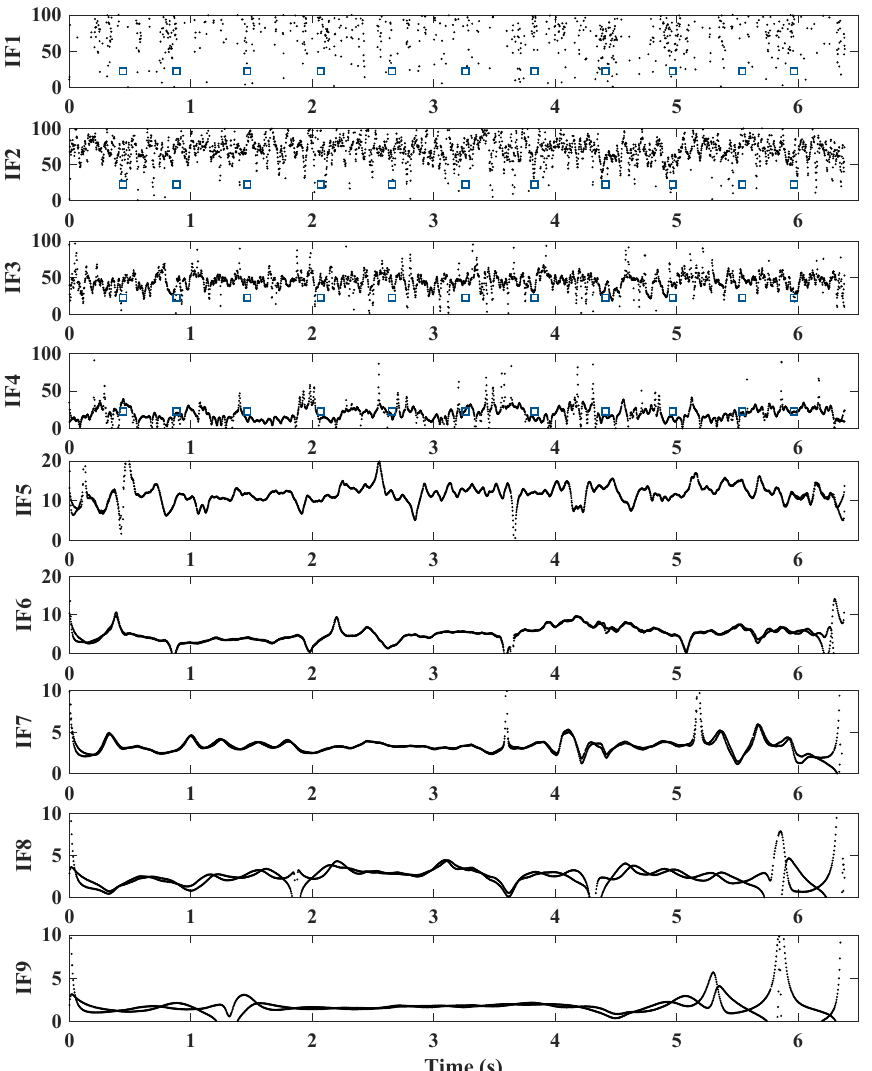
Figure 8. IFs (in time-frequency domain) of an acceleration signal from the instrumented train (dashed lines show the pier locations).